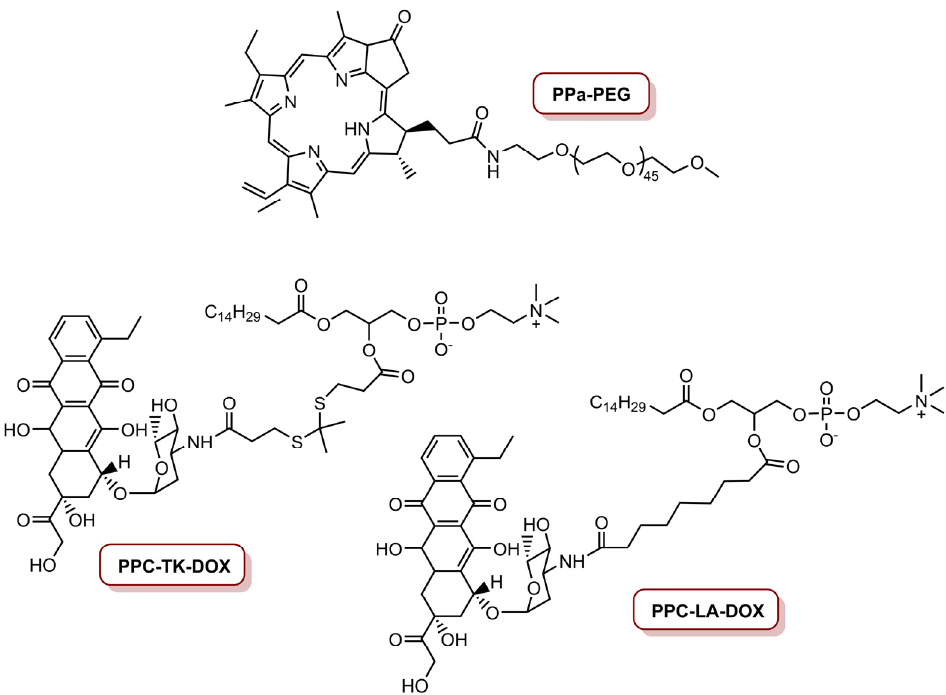
Figure 7. Molecules involved in the preparation of ROS-activatable doxorubicin theranostic prodrug vesicles, PPa-PEG, PPC-TK-DOX and PPC-LA-DOX, respectively, for RADV and RIADV.